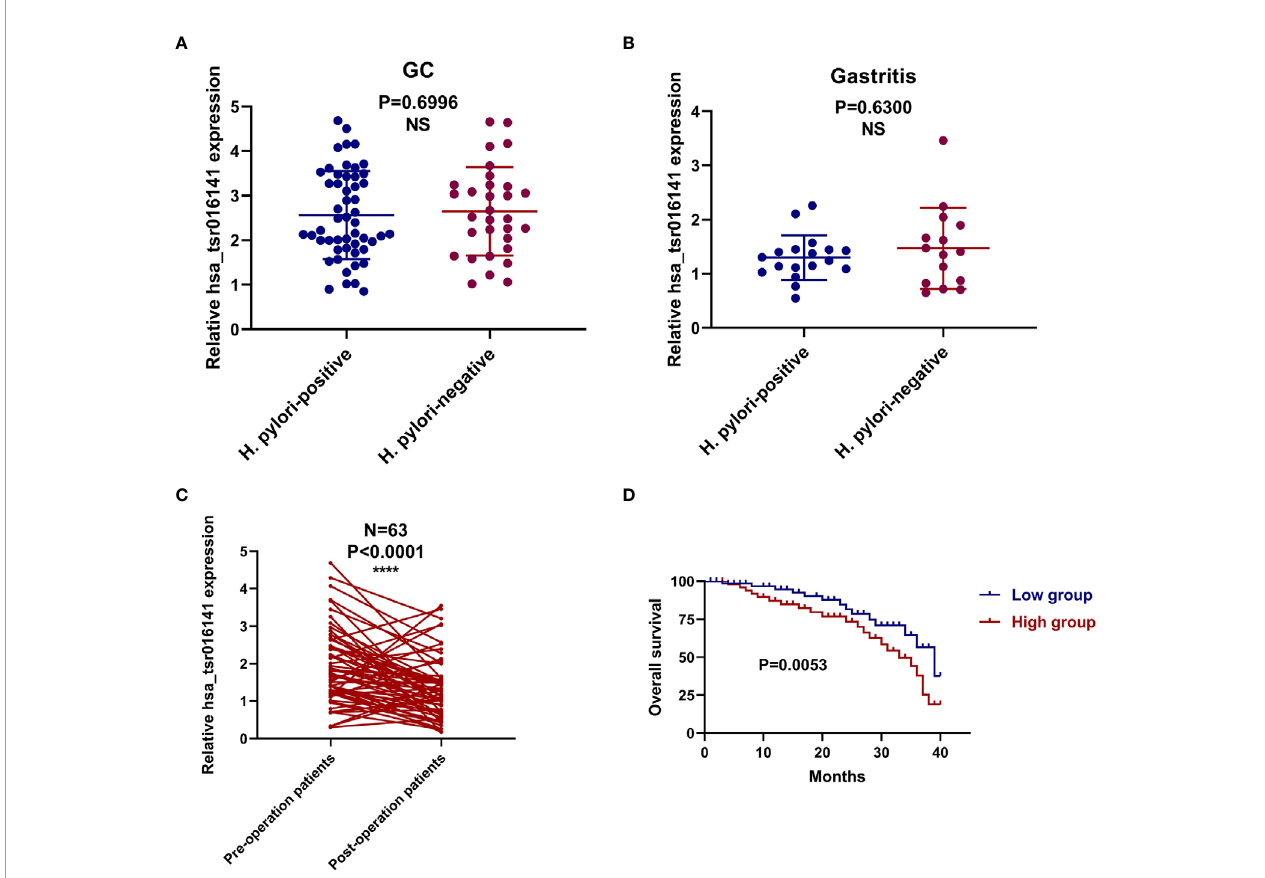
FIGURE 6 | The corresponding relationship with Helicobacter pylori infection and prognostic value of hsa_tsr016141 in GC. (A) The expression level of hsa_tsr016141 between the Helicobacter pylori-positive and Helicobacter pylori-negative groups in GC patients. (B) The expression level of hsa_tsr016141 between the Helicobacter pylori-positive and Helicobacter pylori-negative groups in gastritis patients. (C) The expression levels of the serum hsa_tsr016141 in the 63 GC patients before and after the operation. (D) Survival curve veri fi es the prognostic value of hsa_tsr016141. ****P < 0.0001, NS P >